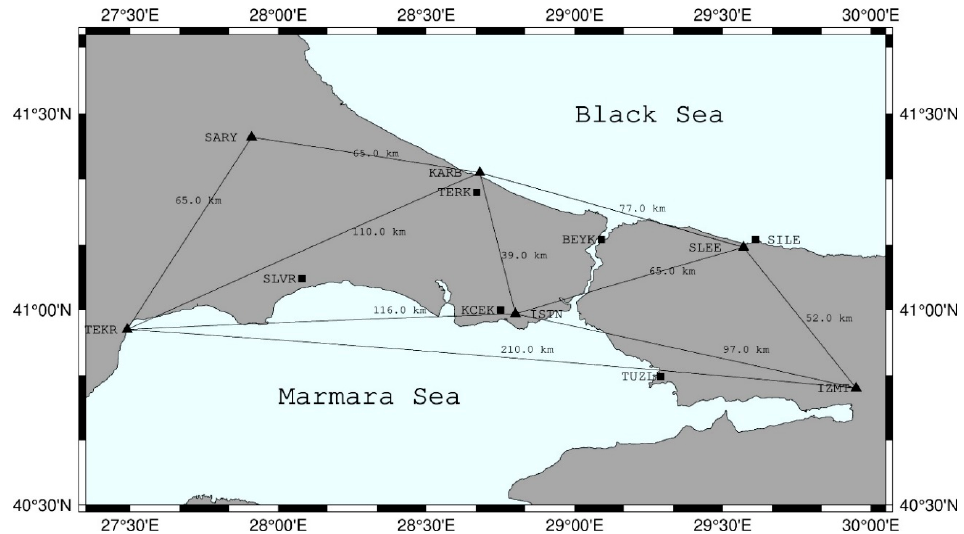
Figure 2. ISKI CORS (rover) and CORS-TR (reference) stations in the study area (square icons represent ISKI CORS network stations; triangular icons represent CORS-TR network stations). ISKI CORS network stations; triangular icons represent CORS-TR network